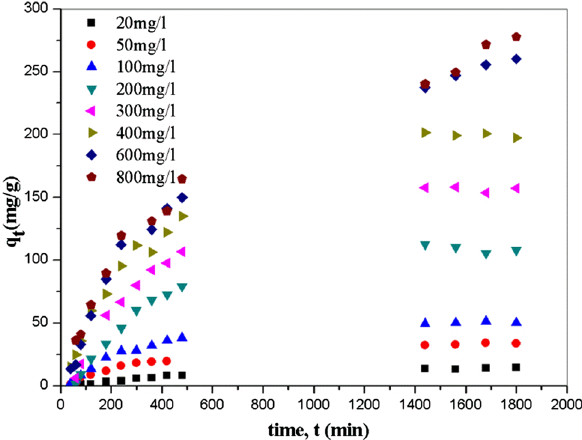
Fig. 7 Kinetic adsorption data for Rh6G on composite at various ini- tial concentrations ( m = 200 mg, V = 200 cm 3 , T = 20 °C, pH = 6)